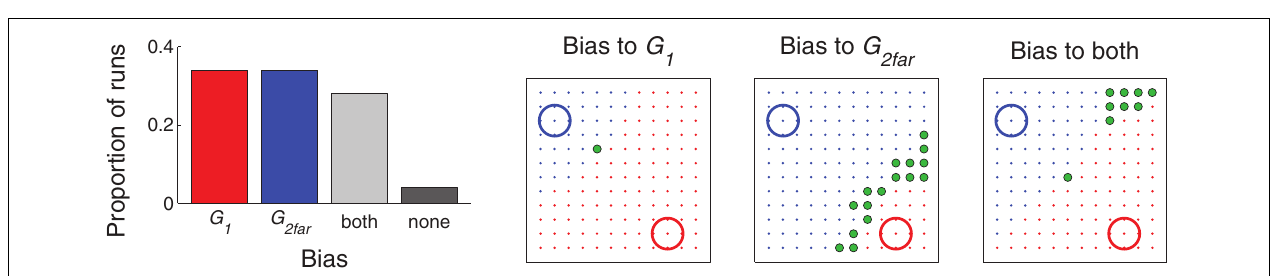
FIGURE 7 | Distribution of movements in Experiment 2: two simultaneous targets. Left: Proportion of runs that were classified as being biased toward one target (more than half of the movements hit target G 1 , red, or G 2far , blue); both targets (more than a quarter of the movements hit G 1 and more than a quarter hit G 2far , gray); or none (all others, black). Right three graphs: example movement distributions for runs that were classified as